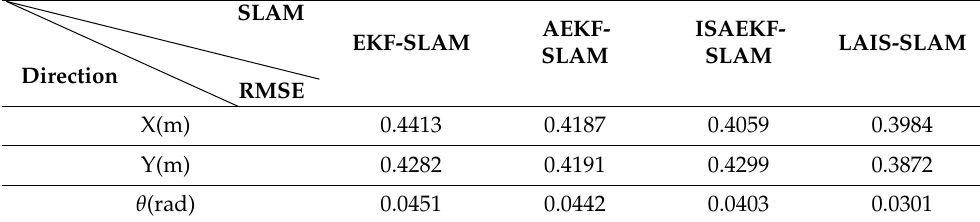
Table 1. The RMSE of each algorithm in three